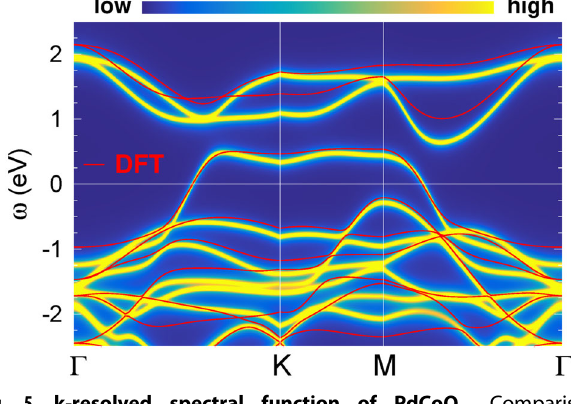
Fig. 5 k-resolved spectral function of PdCoO 2 . Comparison between the DFT band structure (red) and the DFT + DMFT